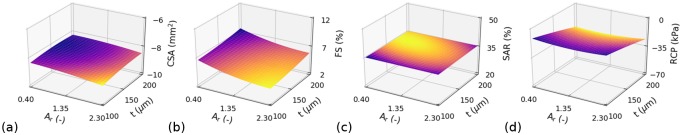
Response surfaces highlighting the combined influence of Ar and t on each performance metric (CSA, FS, SAR and RCP), holding w and l constant at their baseline values (w = 150 μm and l = 1050 μm).